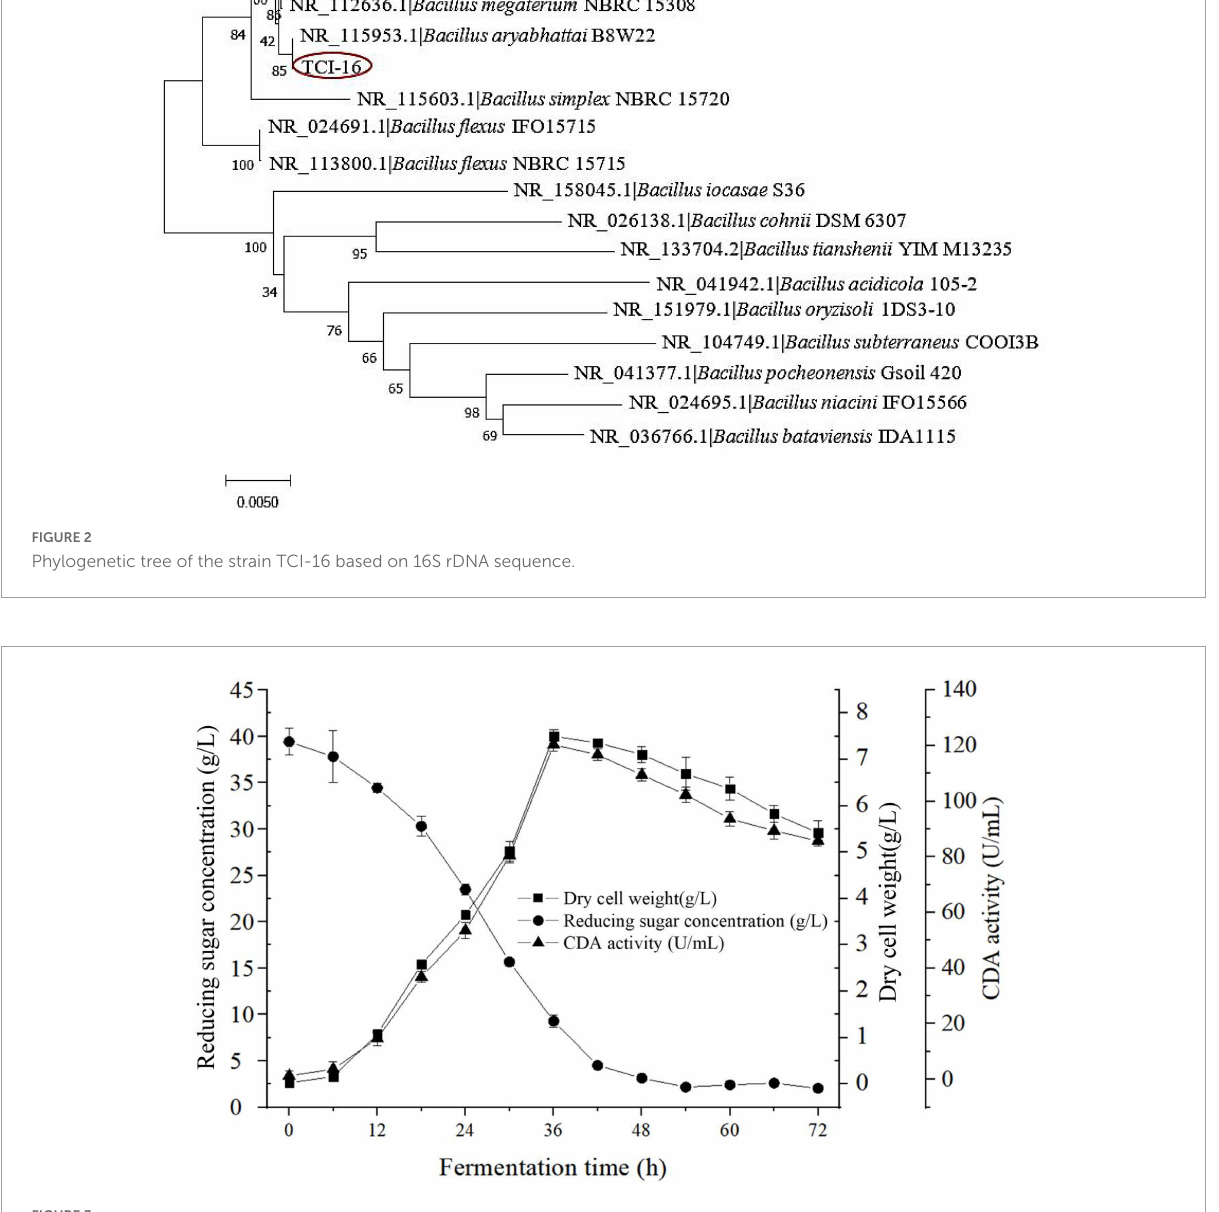
are not a single structure, which are characterized by their degree of polymerization, degree of acetylation, and pattern of acetylation. According to the whole genome annotation with